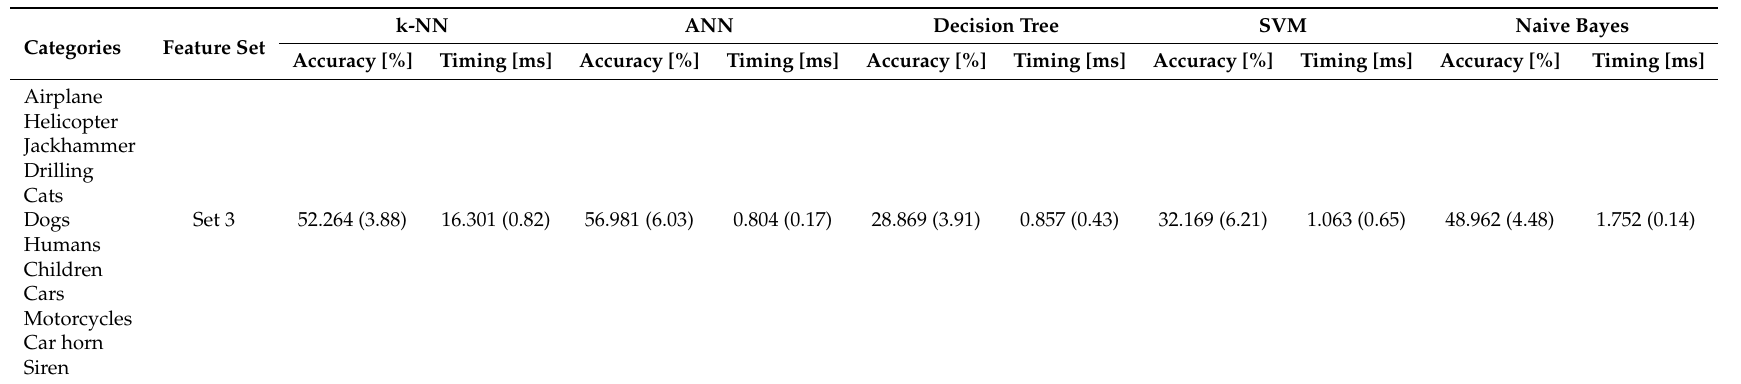
Table 12. Classifiers’ accuracy and timing using an equivalent non-cascade dataset. The Standard Deviation (SD) is in